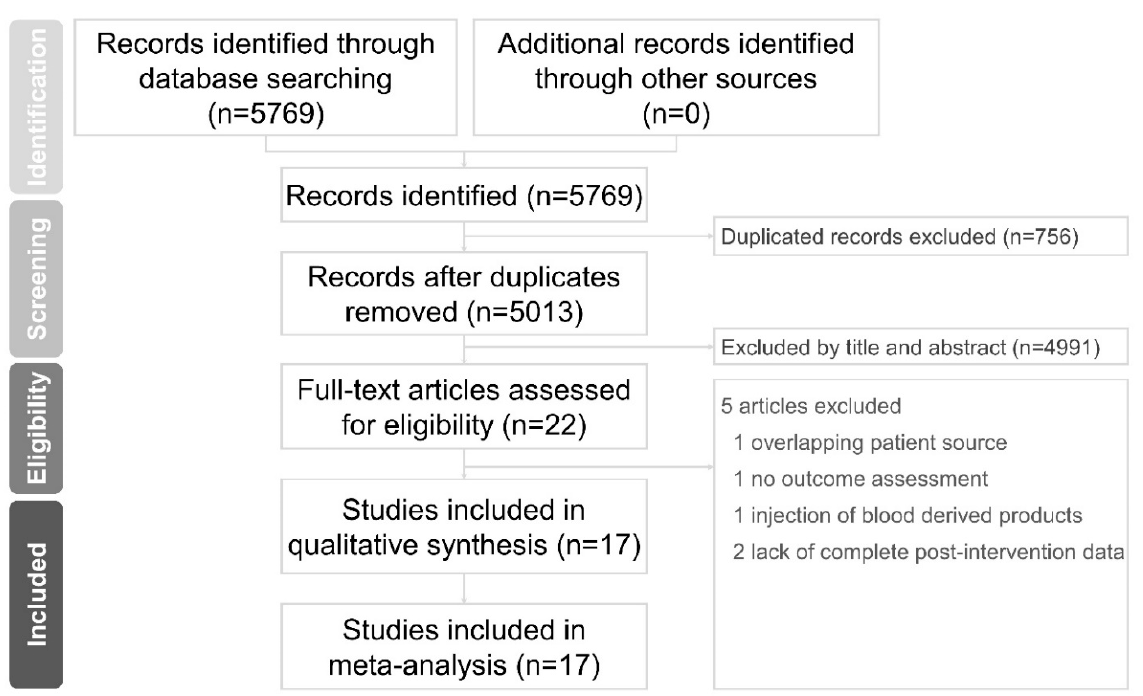
Figure 1. Flow chart of the study selection process. In the 17 enrolled articles [11,12,14,33–46], five trials compared intra-muscular BoNT injections with a placebo [12,35–38], one trial compared intramuscular BoNT injections with intra-articular corticosteroid injections [40], one trial compared intra-muscular BoNT injections with SSNB [39], one trial compared intra-bursal BoNT injections with intra-bursal corticosteroid injections [34], three trials compared intra-articular/bursal corticosteroid in- jections with a placebo [43–45], one trial compared SSNB with intra-articular corticosteroid injections [46], three trials compared SSNB with a placebo [11,41,42], one trial compared HA injections with a placebo [14], and one trial compared HA injections with intra-articular corticosteroid injections [33]. Most of the included studies were double- or triple-blinded RCTs [12,14,35–42,44,46], except one single-blinded RCT [33], one unblinded RCT [43], one quasi-experimental study [11] and one retrospective cohort study [34]. Most of the included studies reported the VAS both in the fourth week and between the 4th and 24th weeks. Assessment of pain was not available at the fourth week in three studies [35,40,45], and between the 4th and 24th weeks in three studies [38,42,43]. Injection guidance were based on ultrasonography in seven studies [11,14,33,34,39,42,44], electromyography in three stud- ies [12,37,38], fluoroscopy in one study [46] and landmark in six studies [35,36,40,41,43,45]. The details of the interventions are listed in Table